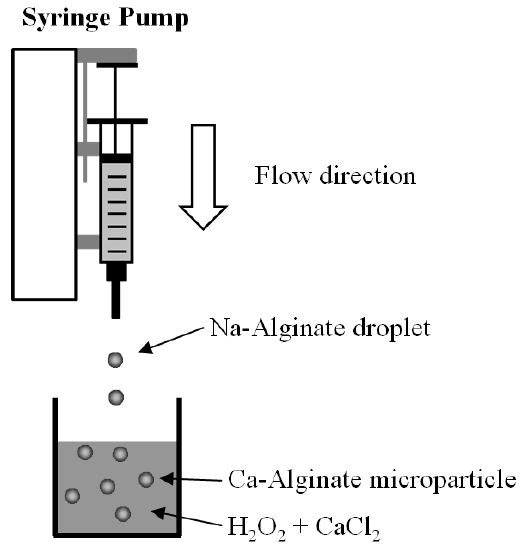
Figure 6. Schematic drawing of the experimental setup.